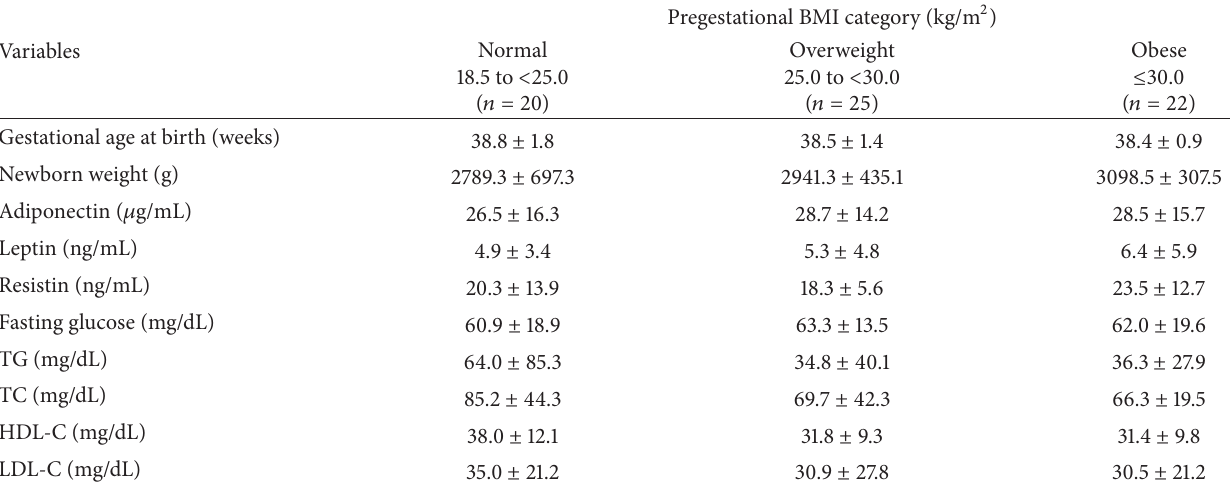
Table 2: Newborn anthropometry and fetal biochemical parameters according to pregestational BMI category.